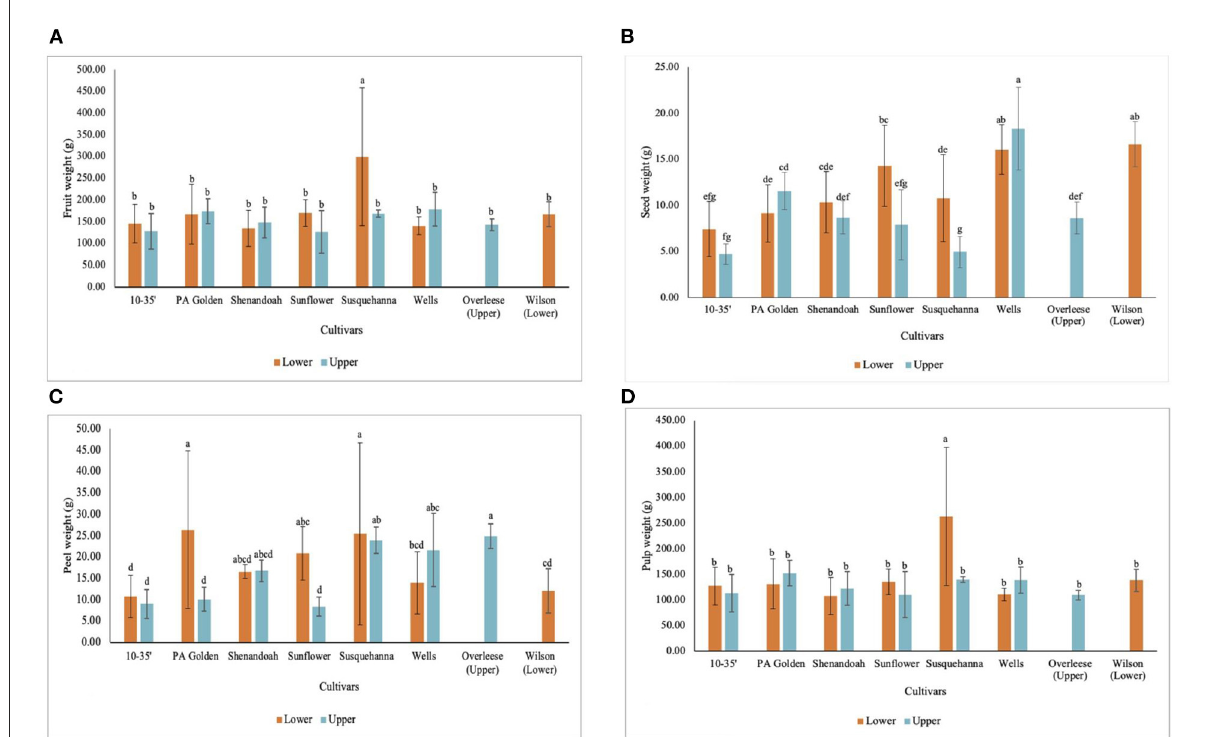
FIGURE3 Weight of (A) fruits, (B) seeds, (C) peels, and (D) pulp of pawpaw fruits from different cultivars in the Lower and Upper orchards.